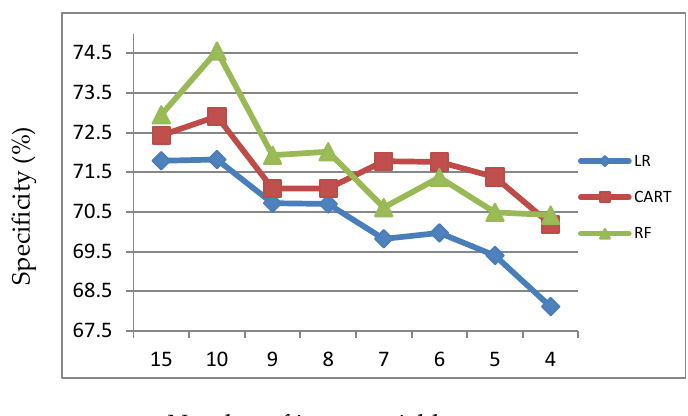
Figure 8. Sensitivity of LR, CART and RF with input of important variables identified by RF.